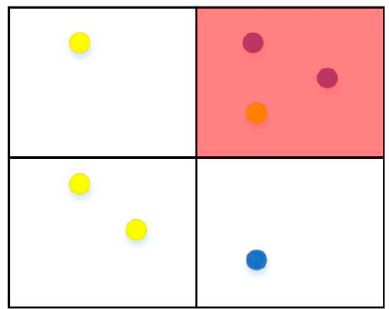
Figure 1. The blue points represent the buildings with type label “school” and the yellow points indicate the buildings with type label “residential buildings”. As a result, the red region is returned as the result of our top-1 query by matching the environmental information of each candidate Region-Of-Interest (ROI) for the query.